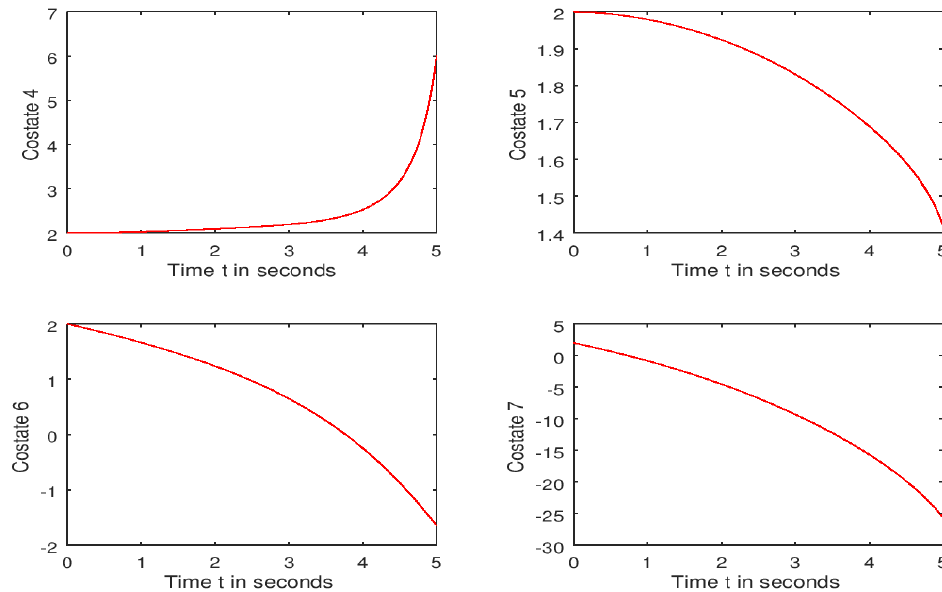
Figure 14. Feasible last four costate trajectories.